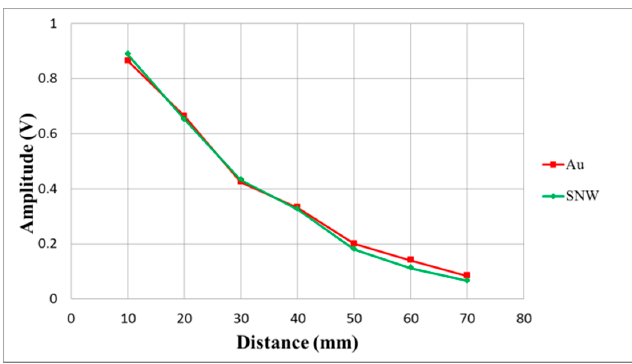
Figure 20. Reflection signals at different detection distances.